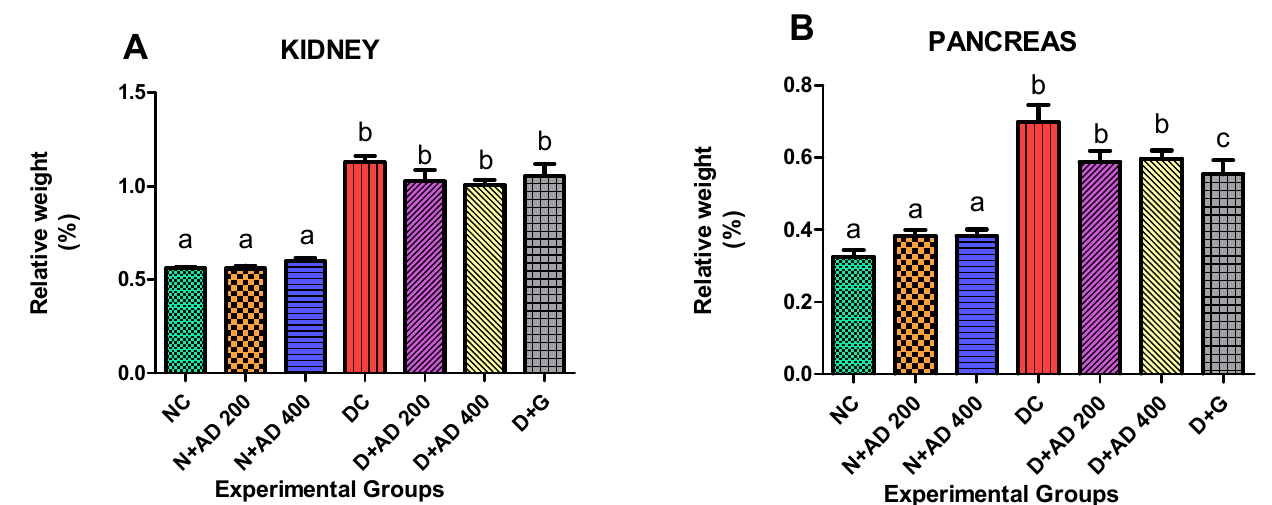
Figure 2. Effect of AD administration on the ( A ) relative kidney weight and ( B ) relative pancreas weight of normal and diabetic rats. Bars are indicative of mean values ± SEM of group values. Bars with different letters are significantly ( p < 0.05) different from each other.